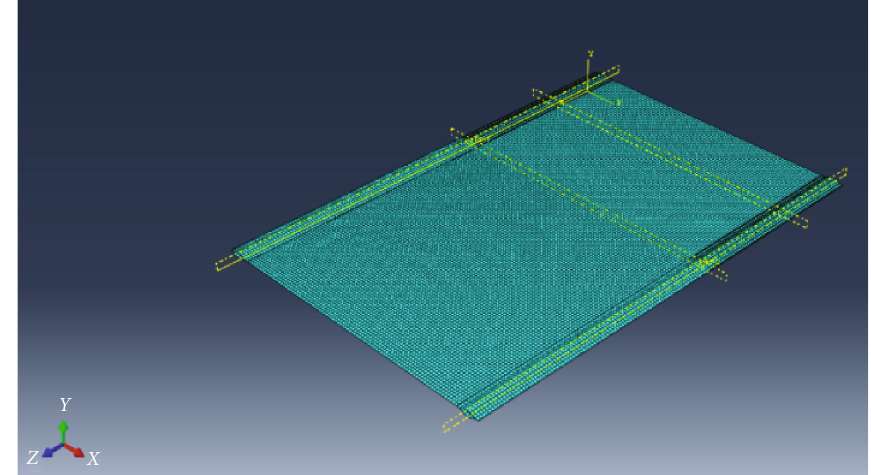
Figure 14: FEA model of the self-deployable